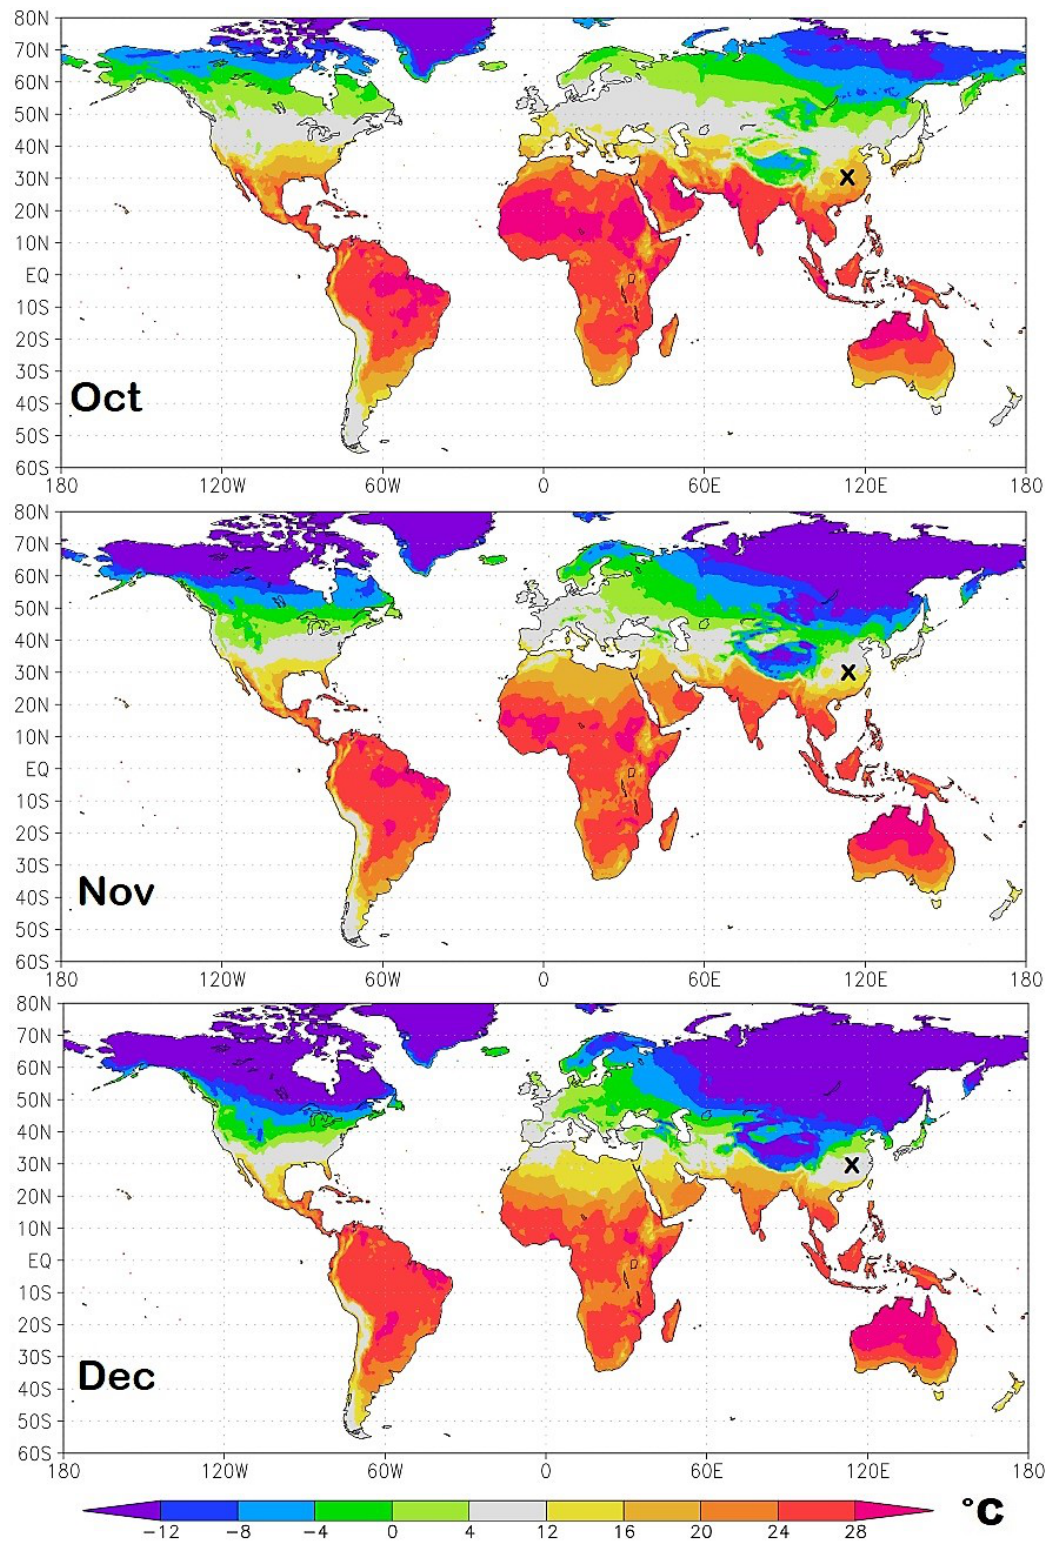
Figure 14. Autumn isotherm world maps from October to December. The small x over China indicates the position of Wuhan. The light-gray zone represents the modeled most exposed regions to the COVID-19